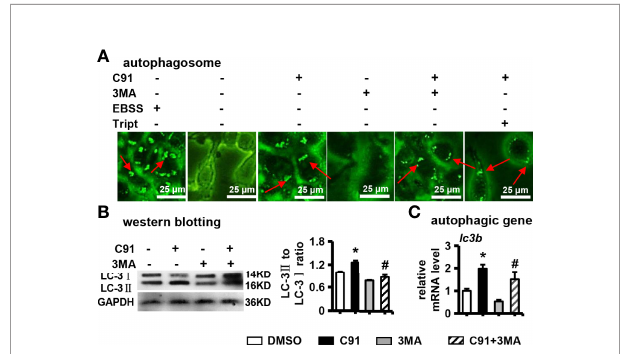
FIGURE 4 | The effect of C91 on autophagy in ST2 cells. (A) 3MA is an autophagy inhibitor. ST2 cells were pre-treated with 3MA (5 mM) for 6 hours, and then induced by C91 for 3 days. MDC staining was performed and autophagy was analyzed by fl uorescence microscopy. Body formation. Red arrows indicate autophagosomes, scale bar = 25 m m. (B) Western blot detection of the expression of autophagy-related protein LC-3I/II. GAPDH was used as an internal control, and the histogram on the right is the quanti fi cation of the band on the left. (C) qRT-PCR analysis of the mRNA expression of autophagy-related gene lc3b . Results are expressed as mean ± SD (n = 3 per group). * indicates P < 0.05, compared with the DMSO group. # indicates P < 0.05, compared with the C91 group.